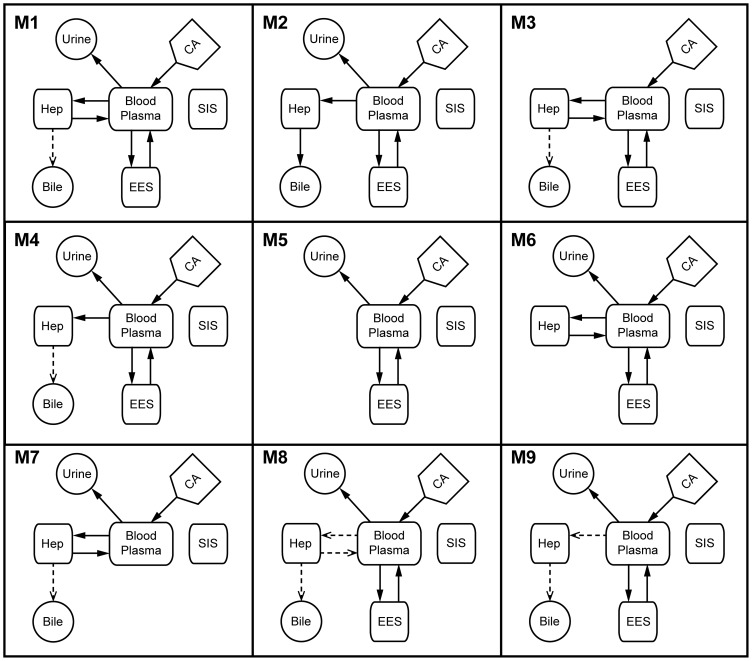
Overview of all tested model configurations.Schematic diagram of the rejected model variants (M1–M9), where the squares represents compartments, circles are the sinks in the model, and the arrows shows the fluxes in the model (see Fig. 2). The signal model (see Fig. 2) was omitted for simplicity and it is identical in all models (M0–M9). The dashed arrows represent the use of Michaelis-Menten kinetics instead of linear mass-action or diffusion like kinetics (as shown by solid arrows).